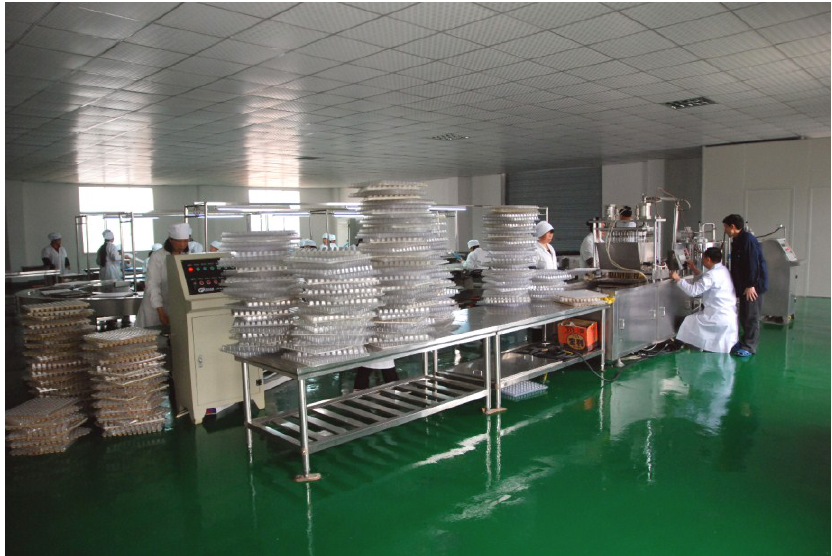
Figure 2. A diet distributing line for rearing H. armigera larvae established in Yichun, Jiangxi Province,